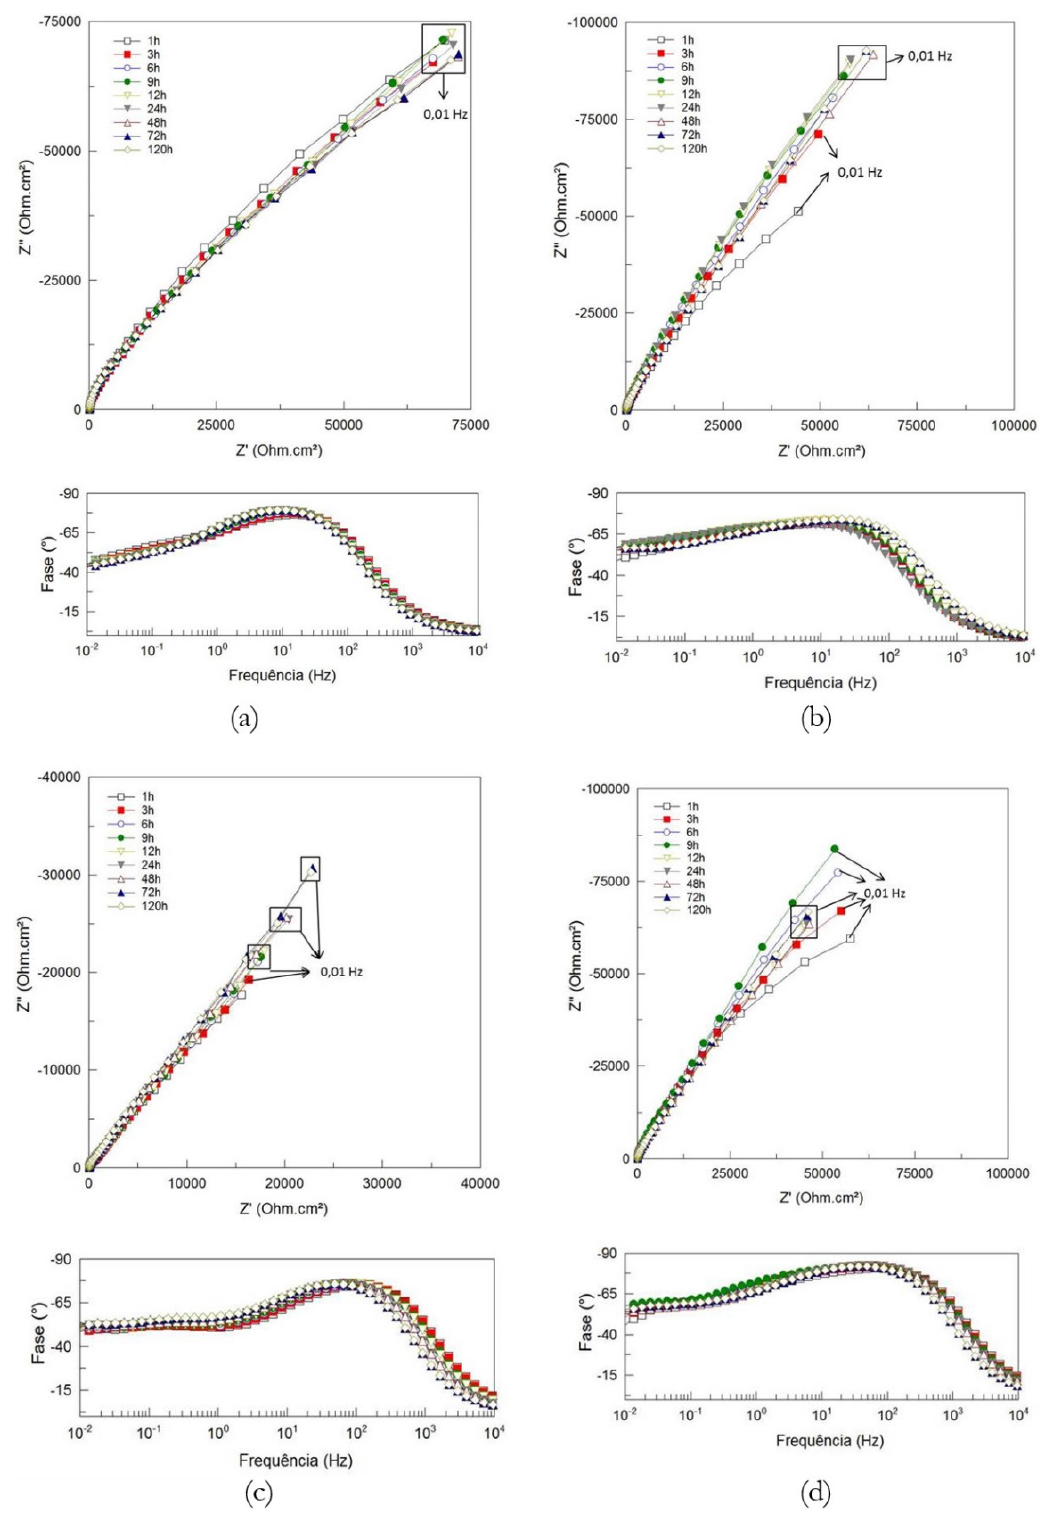
Figure 3. Nyquist and phase angle diagrams (φ versus log f) with immersion time for CA -50 steel in pore water: (a) AP1 (common Portland cement [17]). (b) AP2 (blast furnace slag [17]). (c) 75CPV25EA (75% CP V-ARI + 25% natural steel slag).